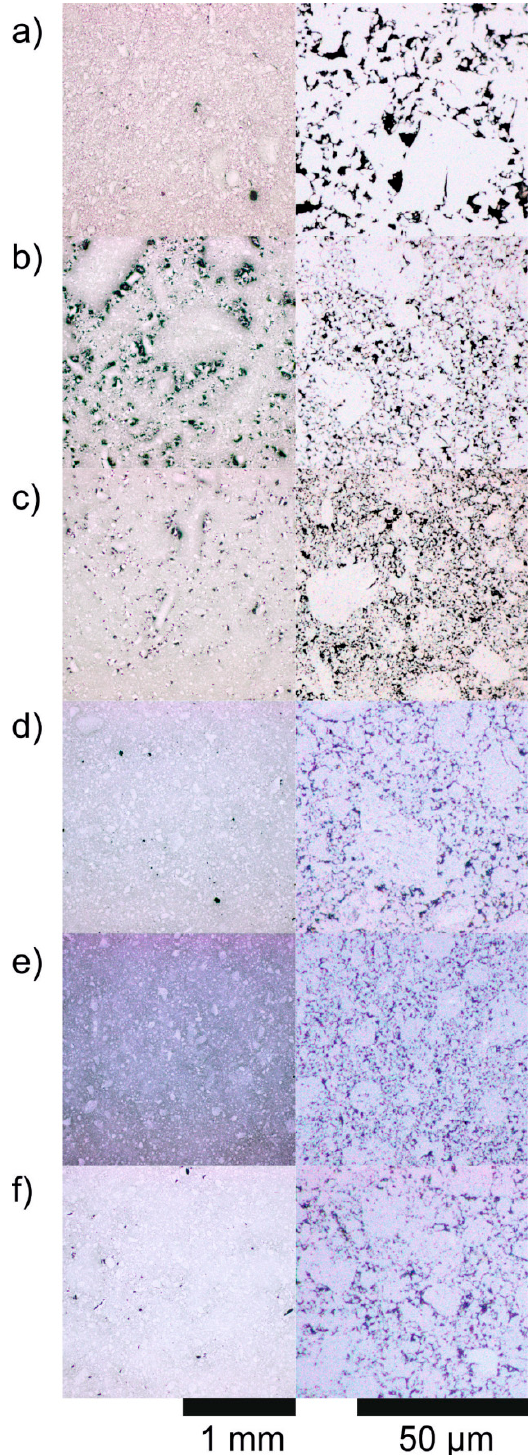
Figure 9. Micrographs of non-etched biocomposites revealing porosities (black in the graph) at different magnifications: Ti23Zr25 (at.%) with ( a ) 3 wt.%, ( b ) 6 wt.% and ( c ) 9 wt.% of 45S5 Bioglass content and Ti23Zr25Nb-9BG doped with ( d ) Ag, ( e ) Cu and ( f ) Zn.